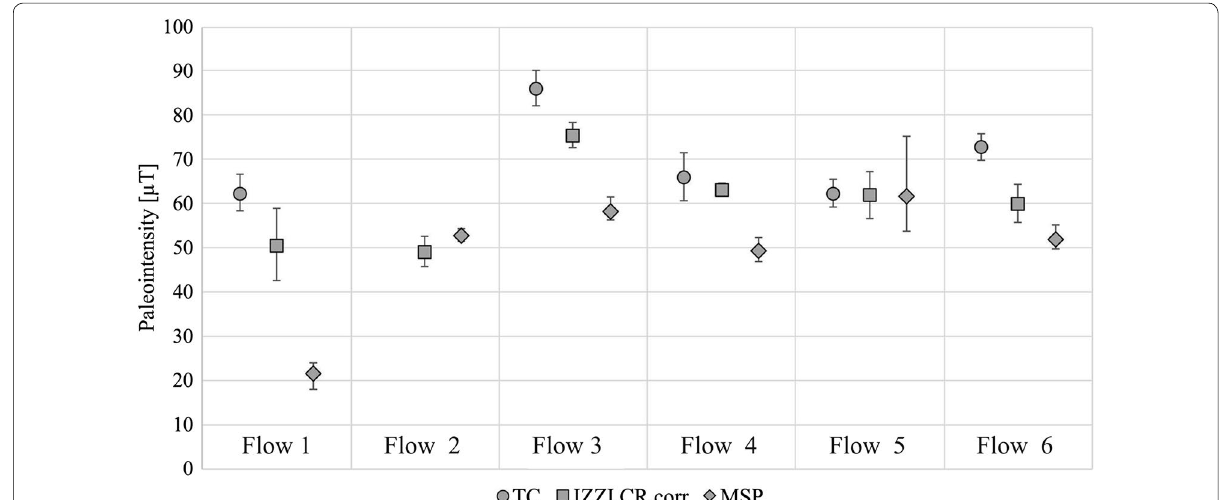
Fig. 6 Comparison of PI results obtained by the different methodologies used (TC, IZZI CRcorr, and MS) for the 6 flows analyzed. Error bars represent the corresponding standard deviations in the case of TC and IZZI CRcorr results, while for the MS data to the Min and Max values obtained